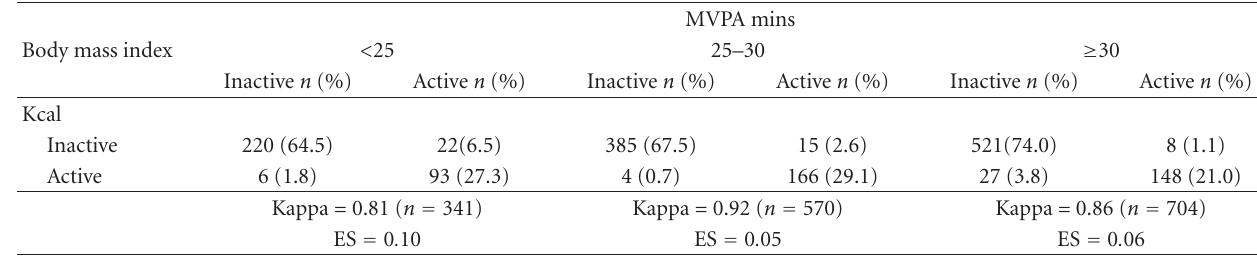
(b) Comparison of agreement between Kcal method and MVPA mins method across BMI categories.